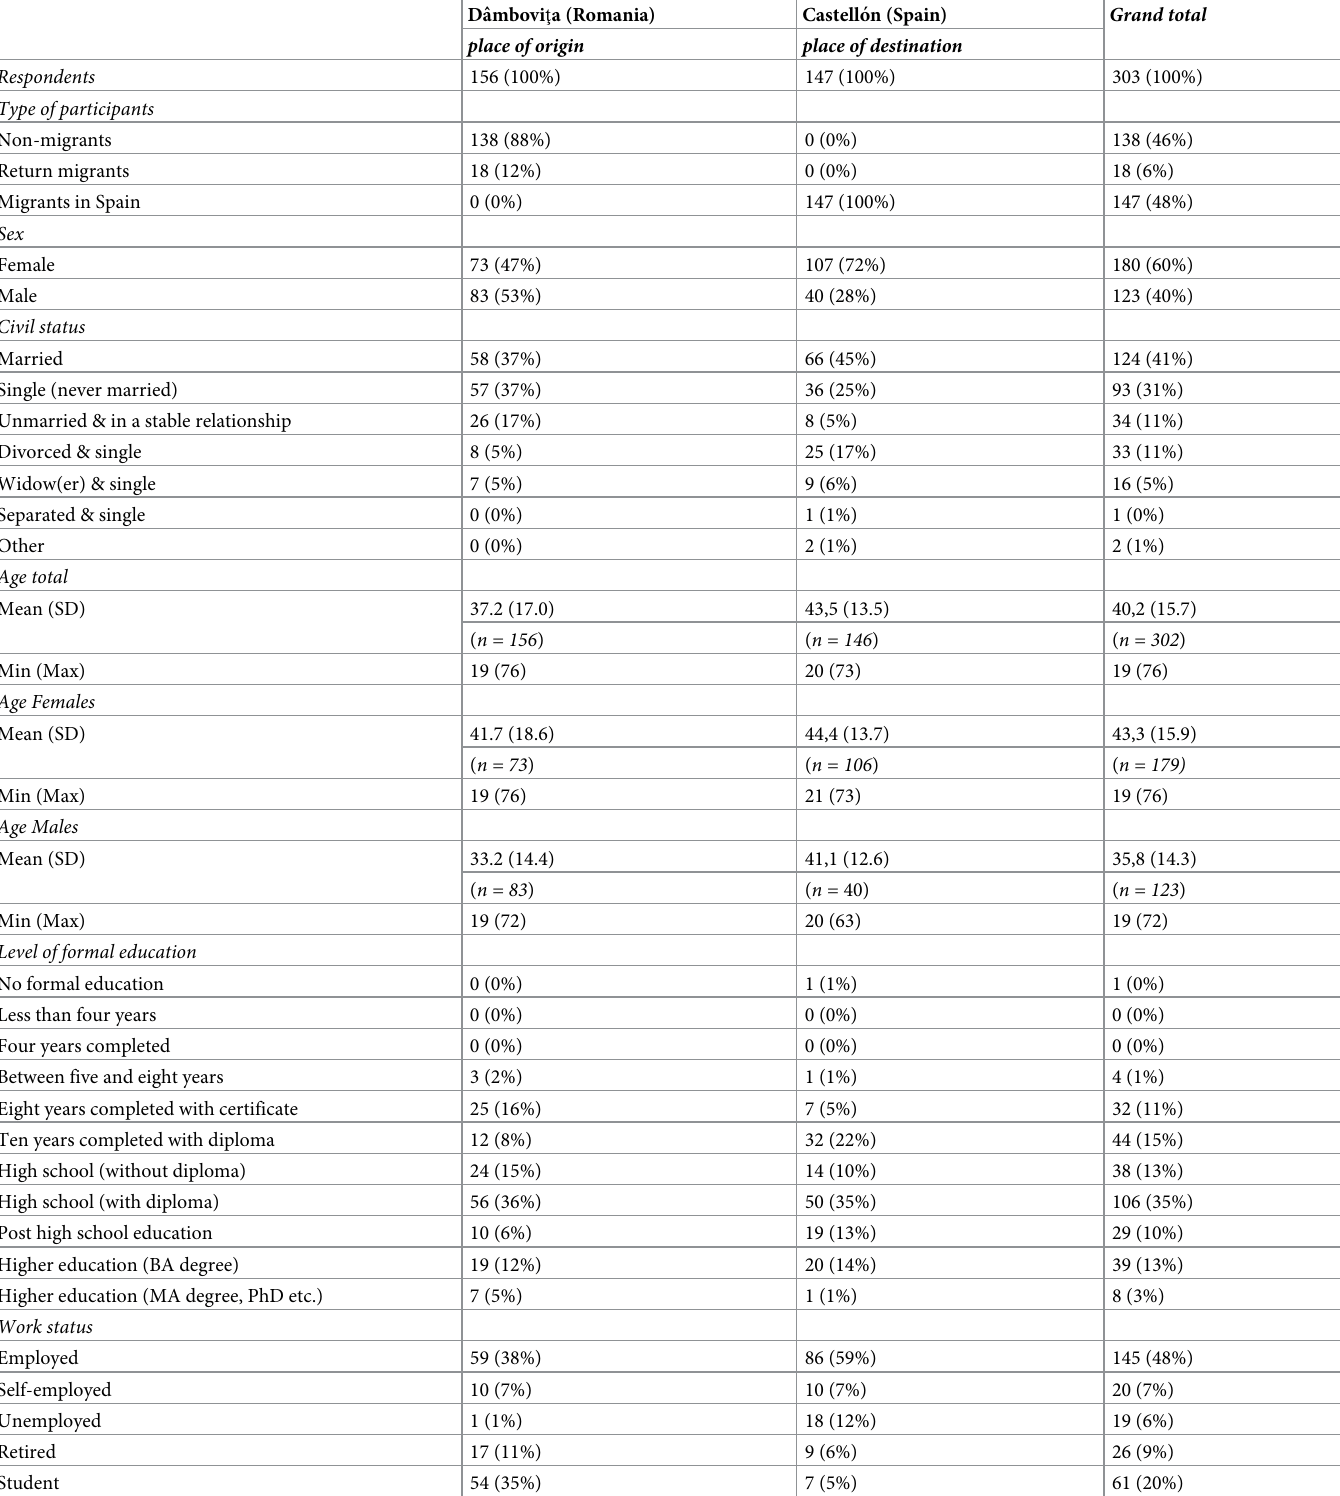
Table 4. Major demographic characteristics of the link-tracing network participants (survey